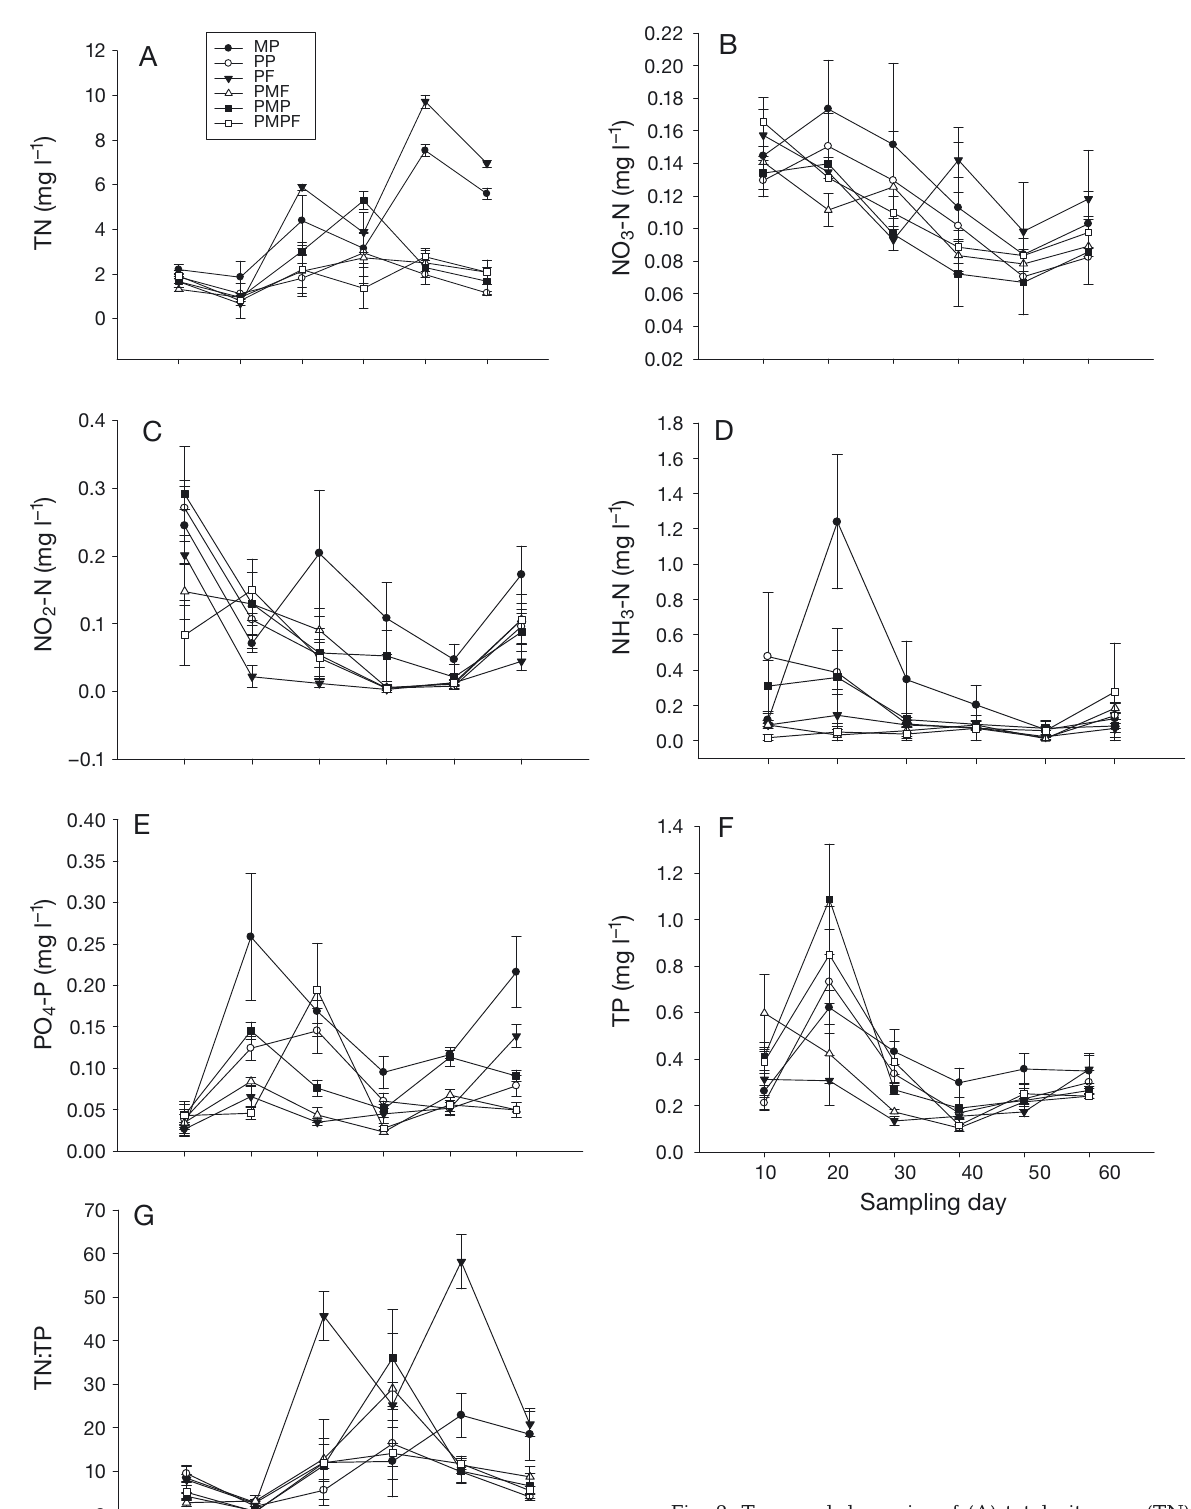
Fig. 2. Temporal dynamics of (A) total nitrogen (TN), (B) NO treatments during the experiment. Data are presented as means ± SE. Treatment groups are defined in Table